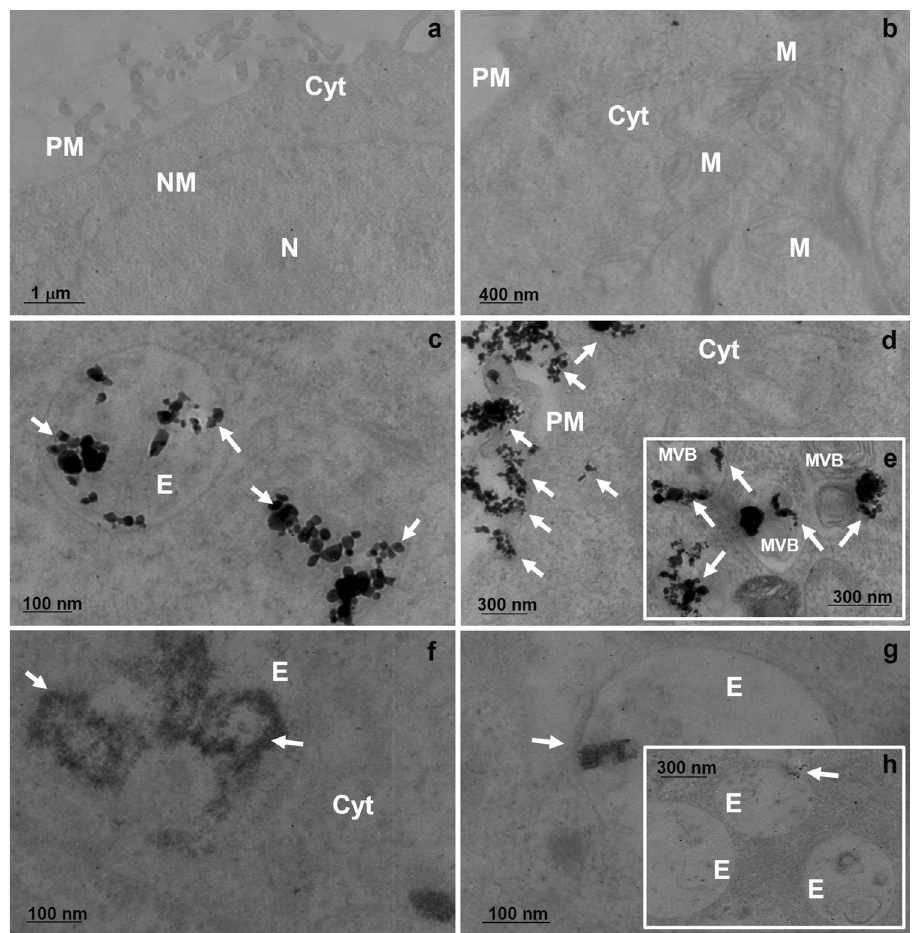
Figure 7. TEM images of A549 exposed to 50 µg/ml CuO NPs. ( a , b ) Negative control cells at 1 h and 3 h post-exposure, with structures like plasma membrane (PM), cytoplasm (Cyt), mitochondria (M), nuclear membrane (NM), intact; ( c ) cCuO NPs already accumulated in endosome-like vesicles (E) at 1 h post-exposure; ( d ) cCuO interacting with the PM and entering cells through the endocytic pathway at 3 h post-exposure; ( e ) inset detailing cCuO accumulating in multivesicular bodies (MVBs) at 3 h post-exposure; ( f ) sCuO already internalised in vesicles at 1 h post-exposure and affecting organelle integrity; ( g ) small aggregates of sCuO NPs in endosomes at 3 h post-exposure; ( h ) detail of sCuO interacting with internal membranes. The white arrows indicate the presence of CuO